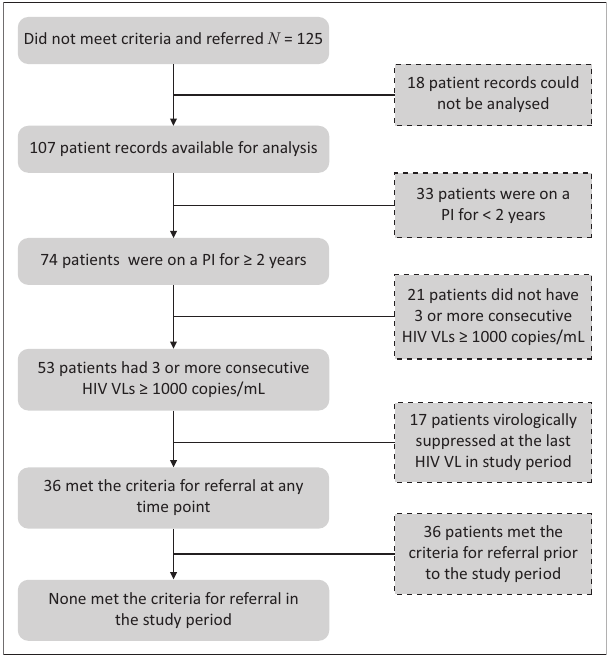
FIG URE 4: Further analysis: ‘Did not meet criteria and referred’ group.